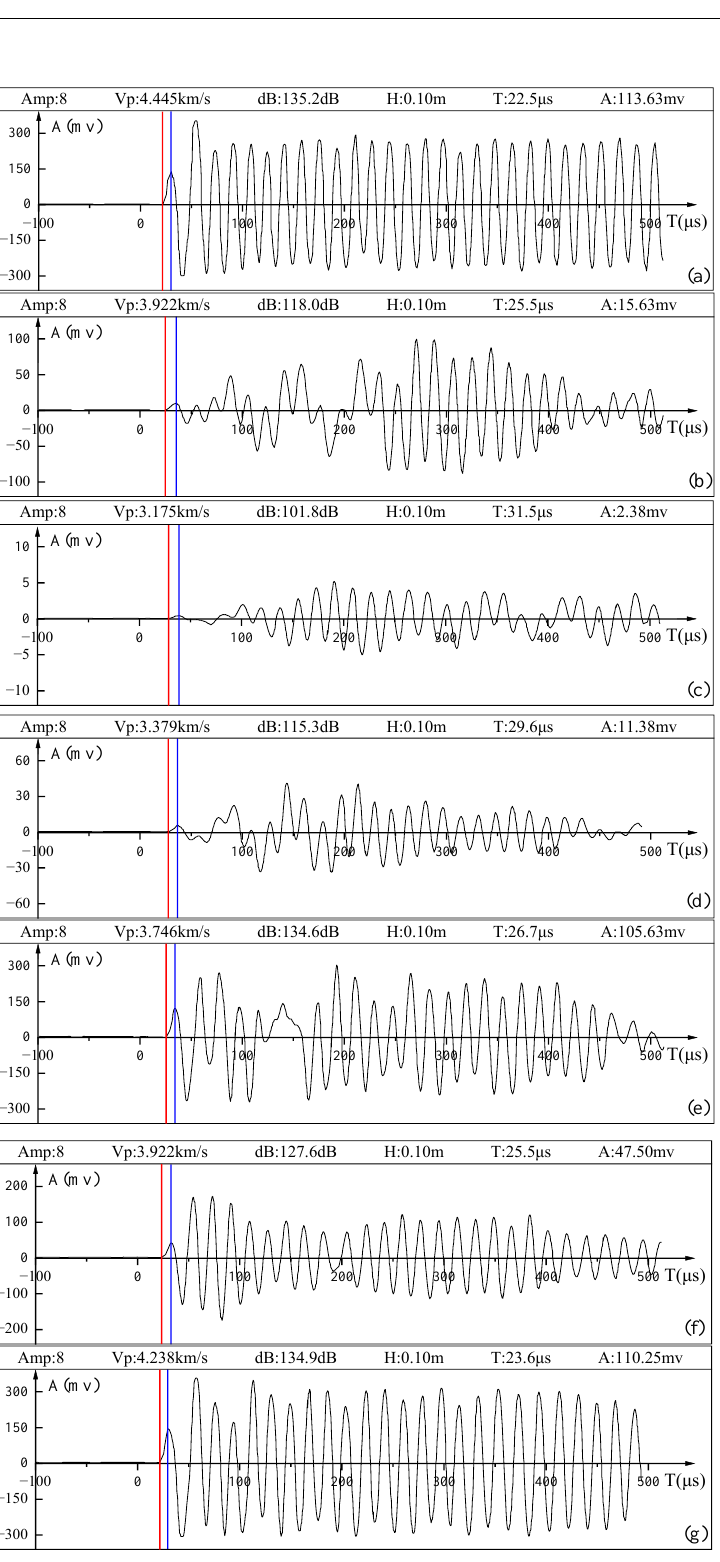
Figure 7. Wave form versus ( a ) original specimen, laser powers of ( b ) 600 W and ( c ) 1000 W, beam diameters of ( d ) 8 mm and ( e ) 12 mm and moving speeds of ( f ) 1 mm/s and ( g ) 4 mm/s.